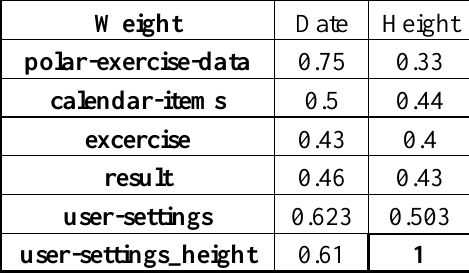
,N ) of concept weight. s T